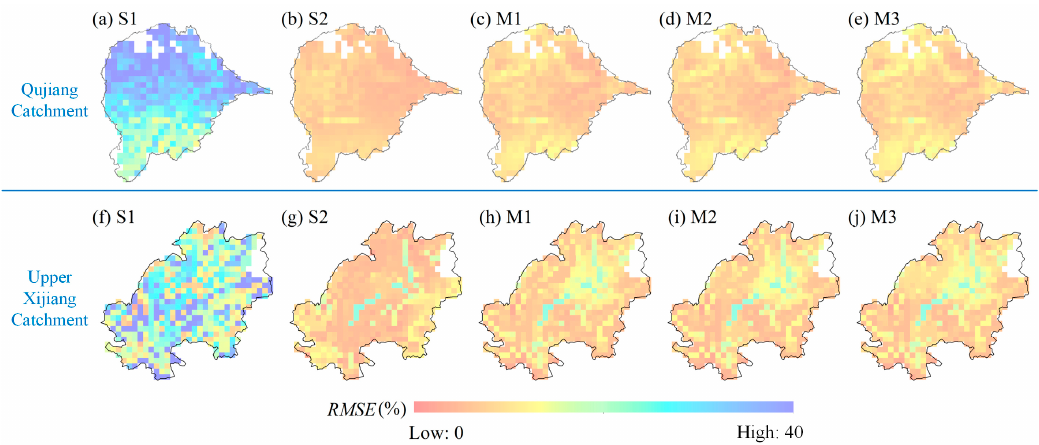
Figure 11. Gridded Root Mean Squared Error ( RMSE ) for SM (%) based on the most likely parameter values in multiple scenarios (S1–S2, M1–M3) during the validation period in Qujiang catchment ( a – e ) and Upper Xijiang catchment ( f – j ).